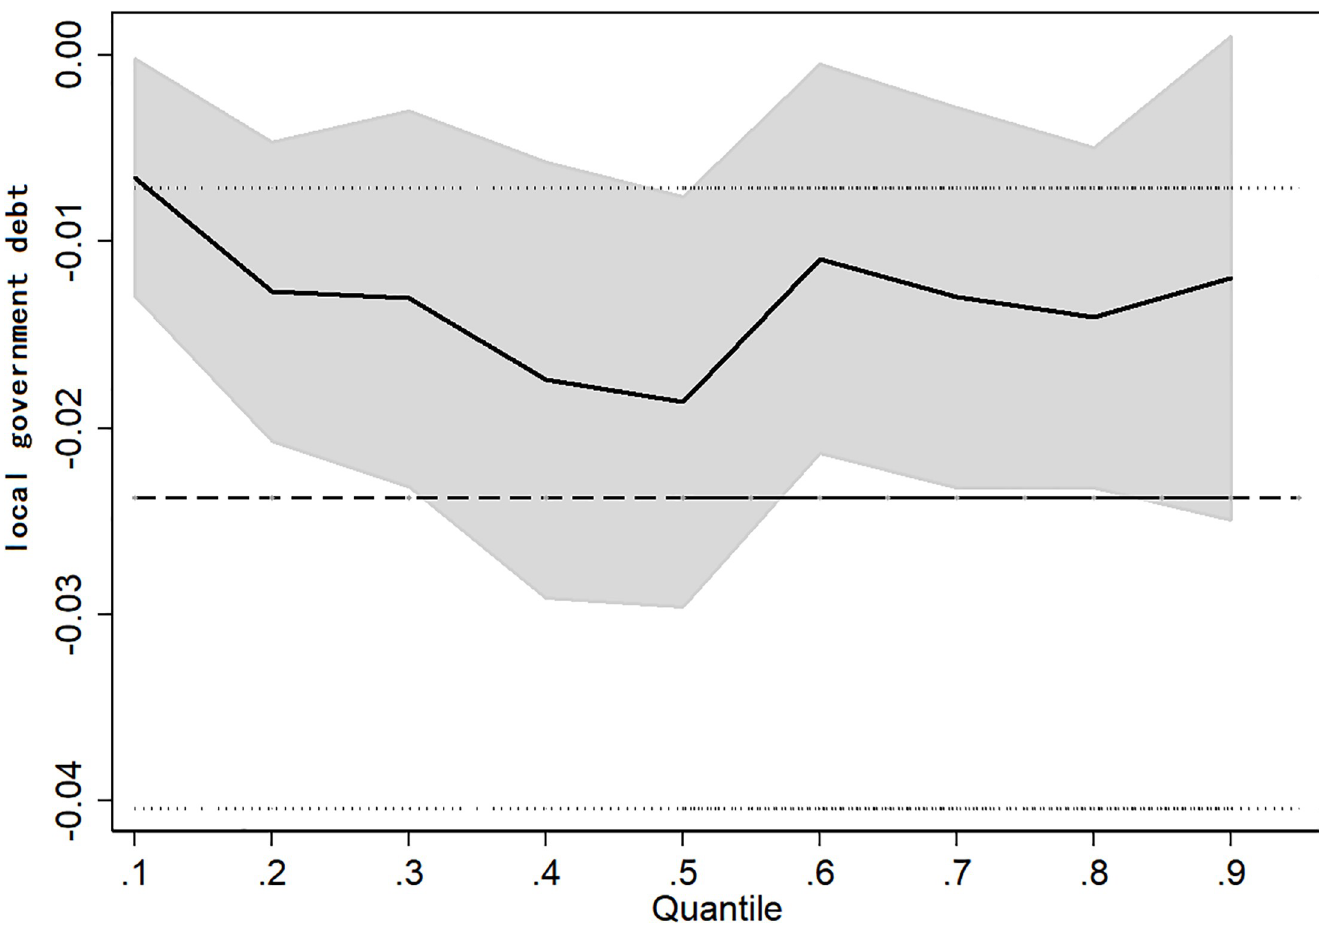
Fig 1. Quantile regression